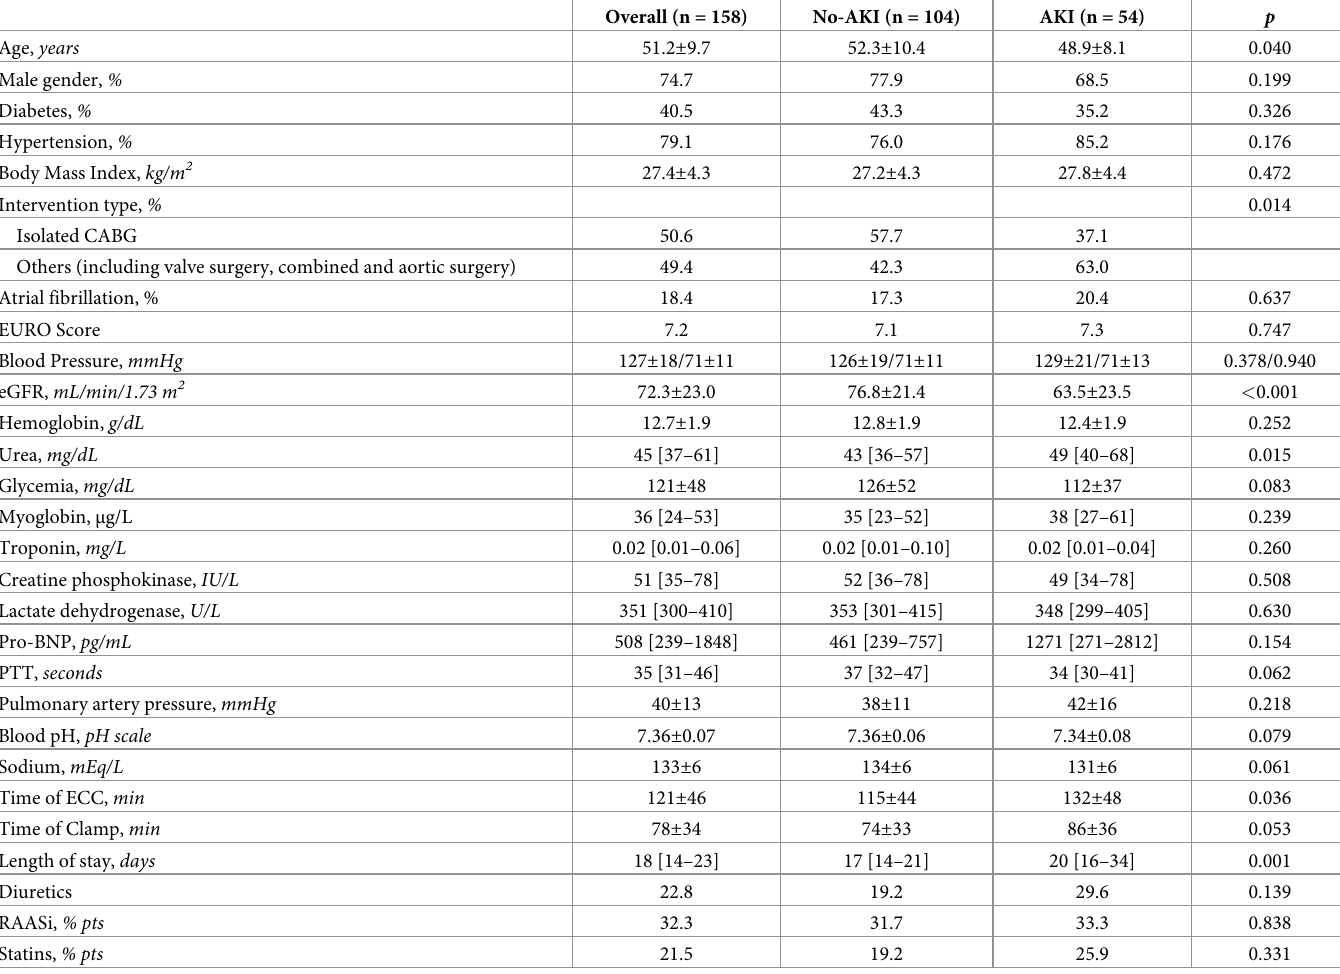
Table 1. Basal characteristics of patients by acute kidney injury (AKI)